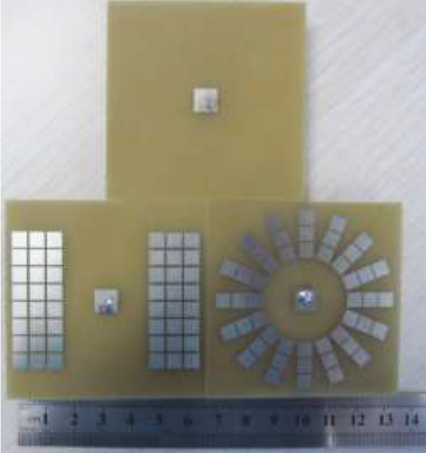
Figure 4: The photograph of antenna with original AMC and GCRA-AMC.